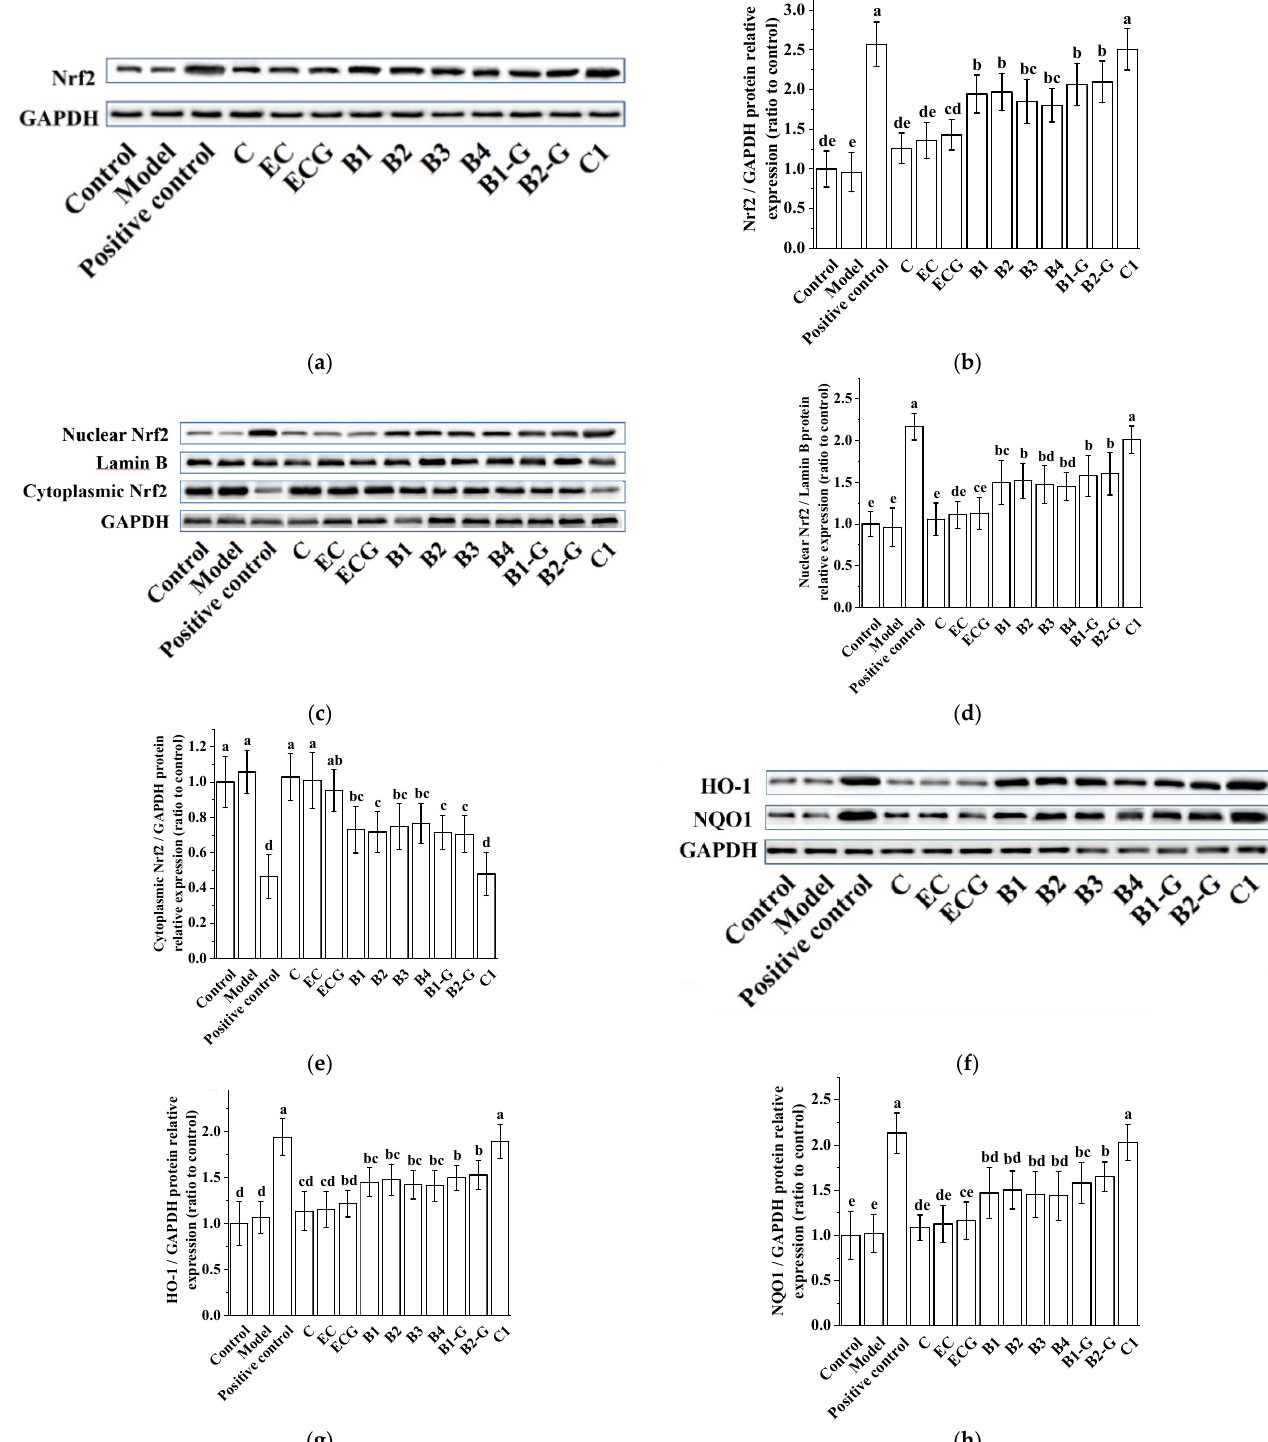
Figure 4. Effects of procyanidins with different structures on the Nrf2/ARE pathway in PC12 cells treated with H 2 O 2 . ( a ) Protein levels of Nrf2, as determined by Western blotting; ( b ) Relative Nrf2/GAPDH protein expression (ratio to control); ( c ) Protein expression levels of nuclear Nrf2 and cytoplasmic Nrf2, as determined by Western blotting; ( d ) Relative nuclear Nrf2/Lamin B protein expression (ratio to control); ( e ) Relative cytoplasmic Nrf2/GAPDH protein expression (ratio to control); ( f ) Protein levels of HO-1 and NQO1, as determined by Western blotting; ( g ) Relative HO-1/GAPDH protein expression (ratio to control); ( h ) Relative NQO1/GAPDH protein expression (ra- tio to control). Data are expressed as the mean ± SD. Control, Blank control group; Model, H 2 O 2 (200